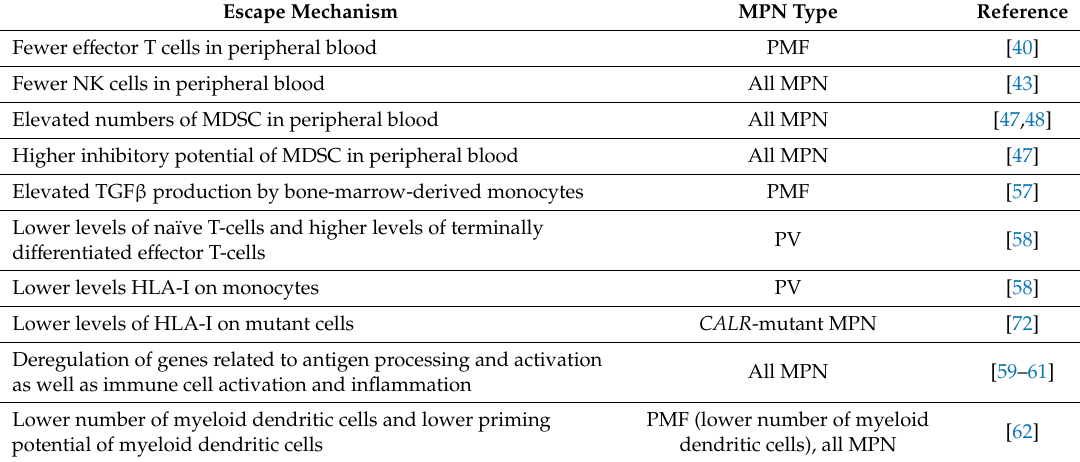
Table 1. Immune-suppressive mechanisms identified in myeloproliferative neoplasms (MPN). Primary myelofibrosis (PMF), natural killer cells (NK cells), myeloid derived suppressor cells (MDSC), human leucocyte antigen (HLA), polycythemia vera